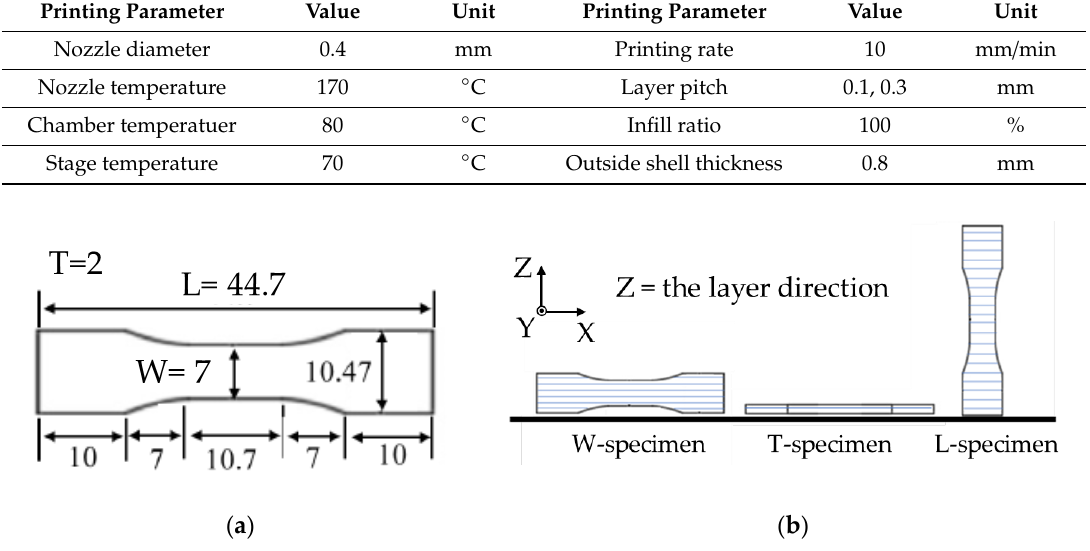
Figure 1. Overview and a picture of the 3D-printing system. Table 1. FDM 3D print conditions.